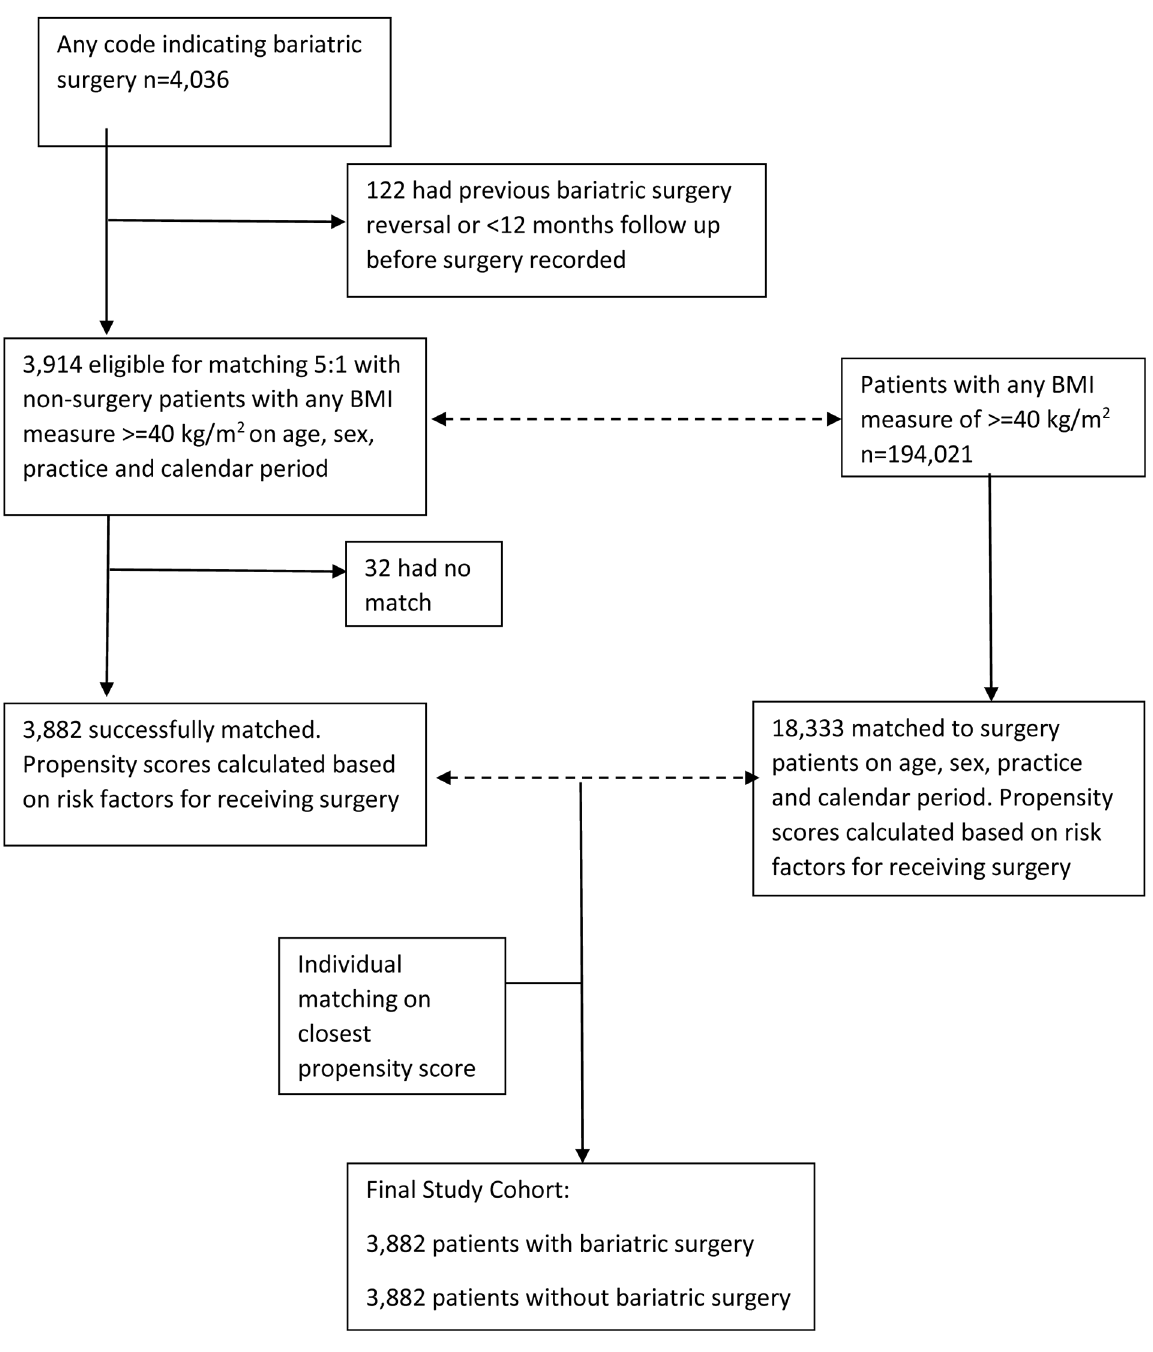
Fig 1. Flow diagram of study